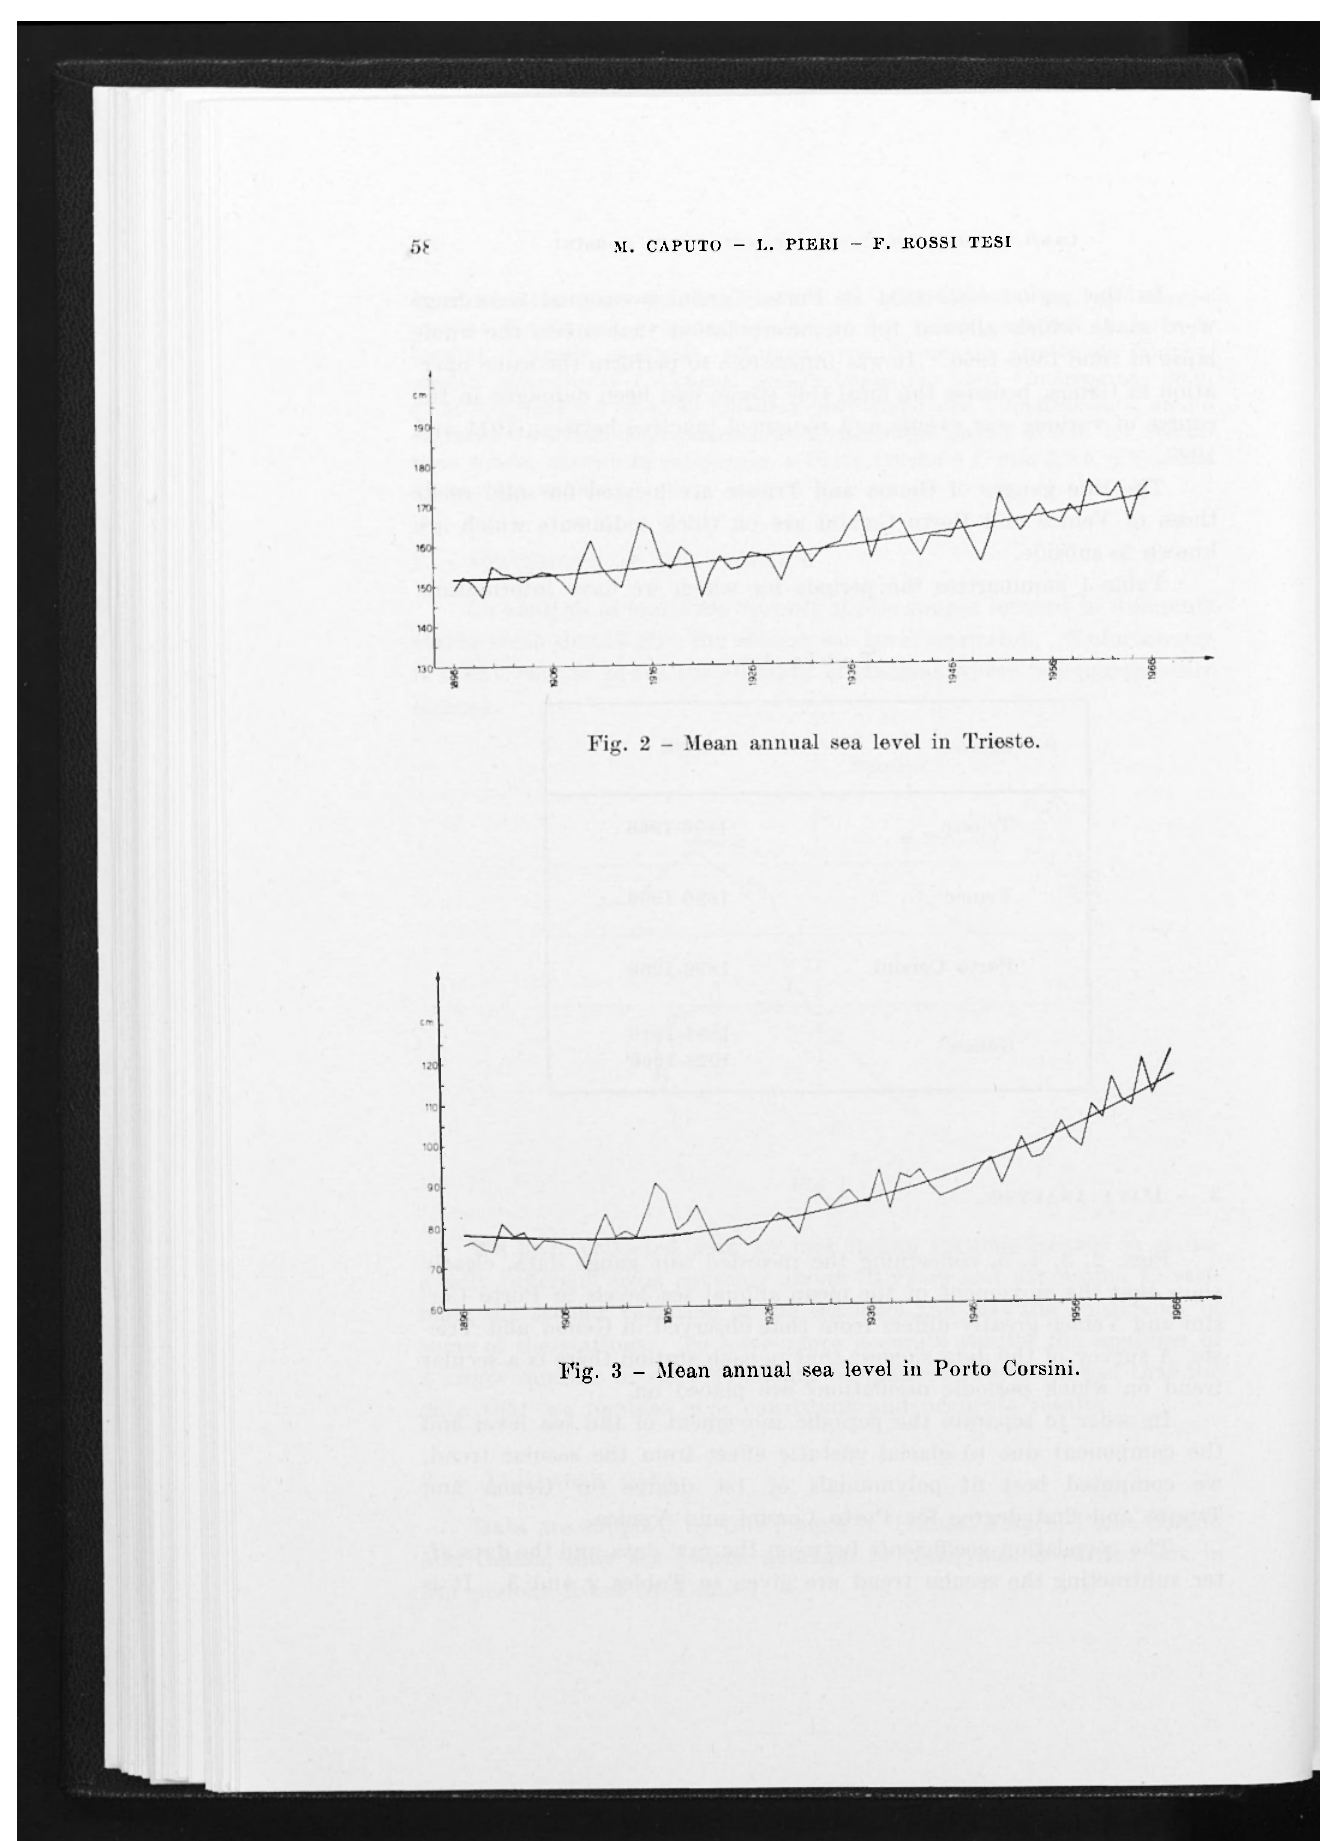
Fig. 3 - Mean annual sea level in Porto